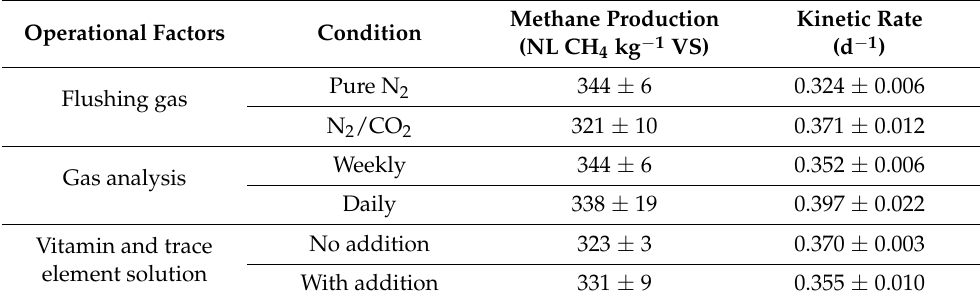
Table 3. Impact of the operational factor on the BMP kinetic and methane production of cellulose. Operational